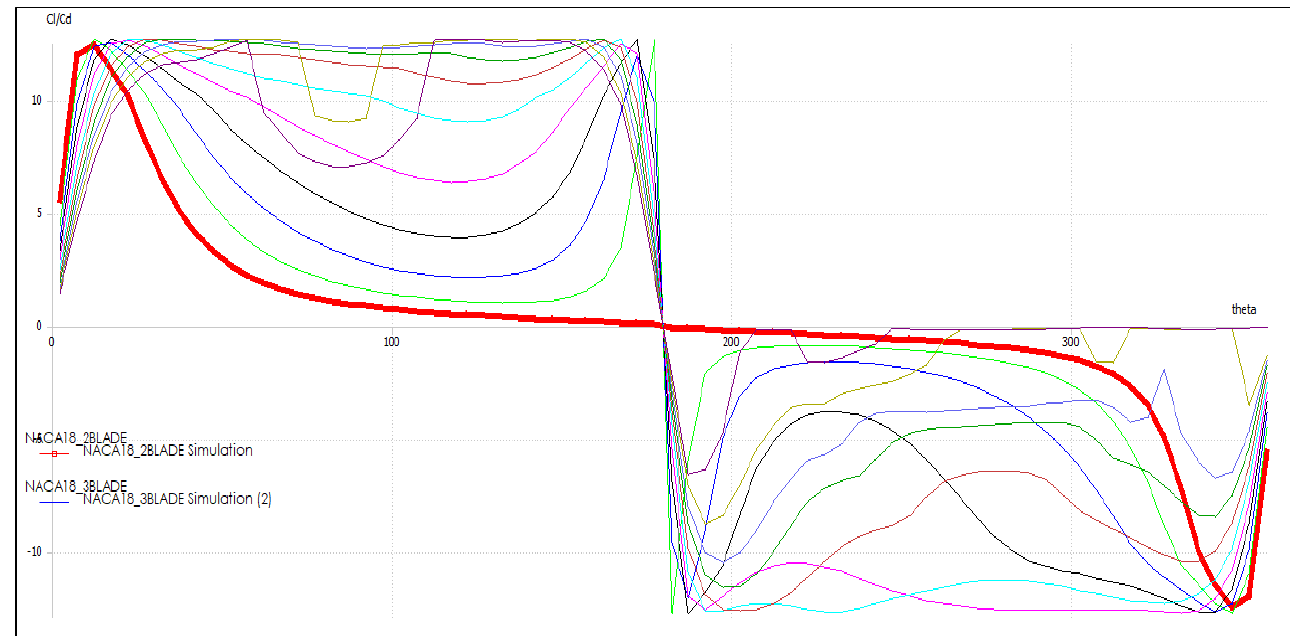
Figure 24. Cl/Cd vs theta plot of mid-section for TSR